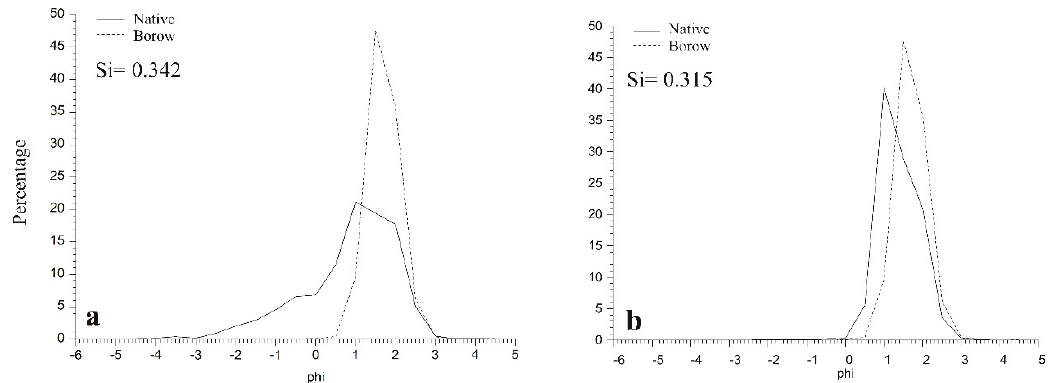
Figure 6. Grain size distribution of the composite sample formed with the 14 cores taken on the 4500-meter-long southern Viareggio Sector (10, borrowed sand) and those of the beach of Sector 5 ( a , native sand at Ronchi) and 12 ( b , native sand at R. Morto beach).